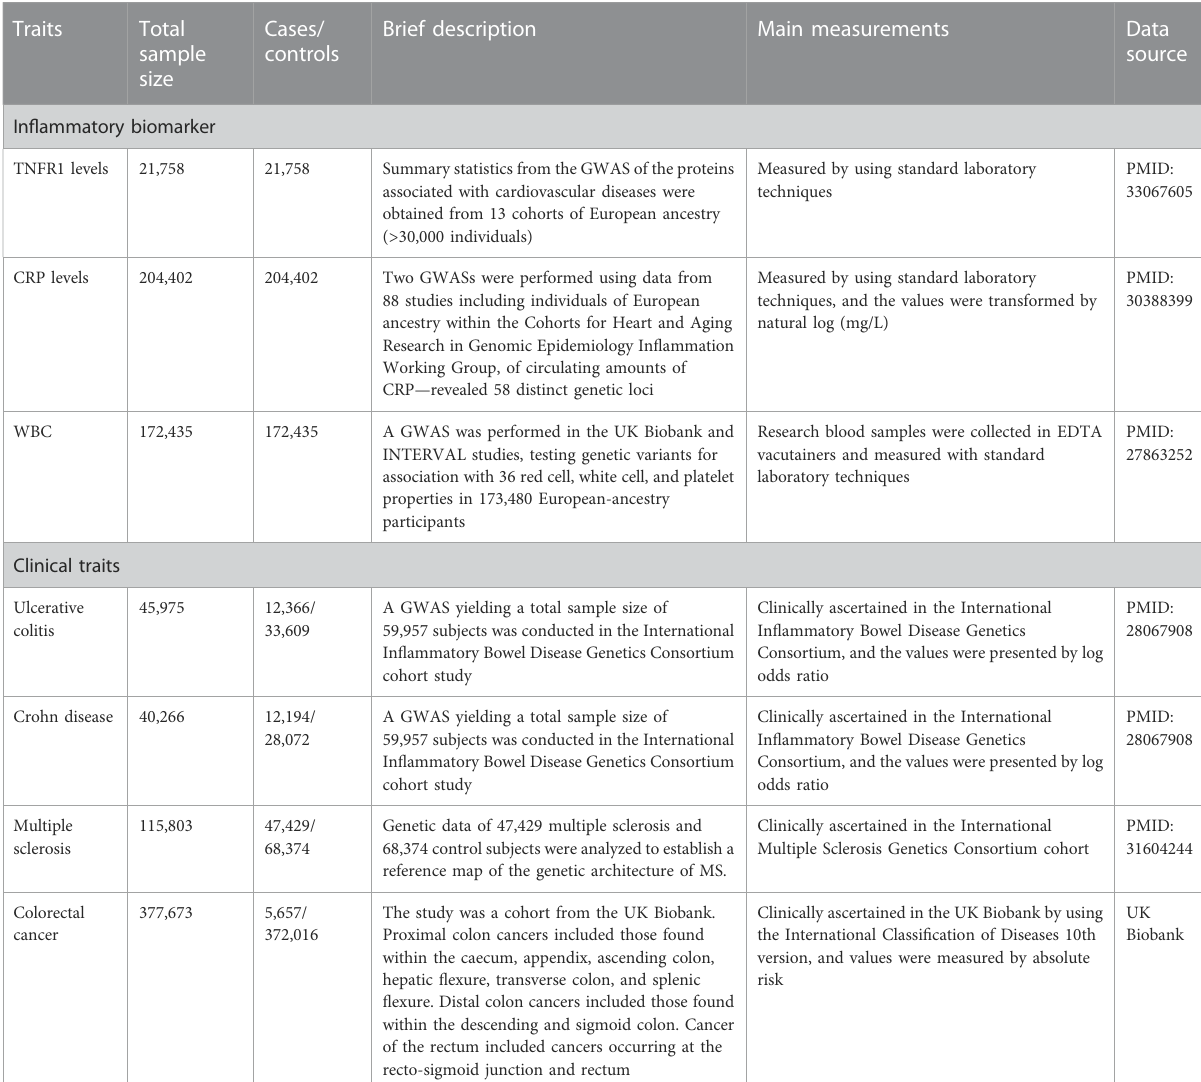
TABLE 1 Characteristics of the included